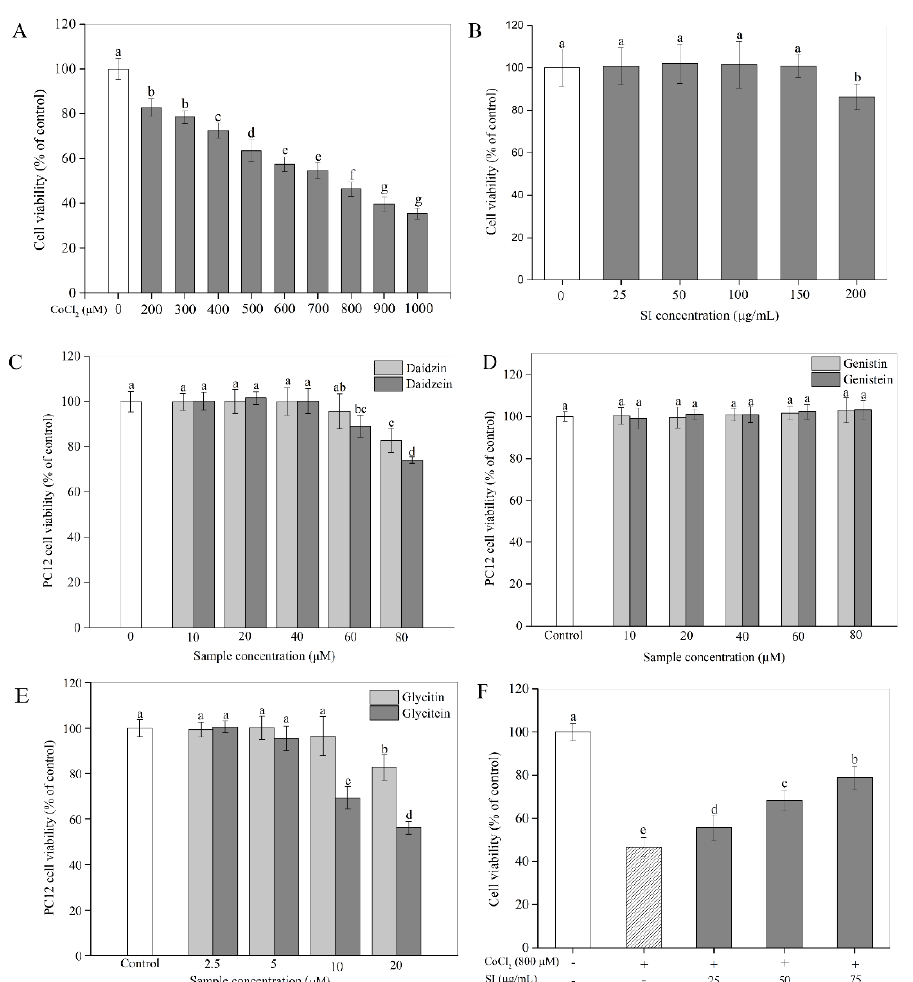
Figure 1. Cytotoxicity and the protective effect of SIs on CoCl 2 − induced cell viability loss. ( A ) Cyto- toxicity of CoCl 2 . ( B ) Cytotoxicity of SIs. ( C ) Cytotoxicity of daidzin and daidzein. ( D ) Cytotoxicity of genistin and genistein. ( E ) Cytotoxicity of glycitin and glycitein. ( F ) The protective effect of SIs on CoCl 2 − induced cell viability loss. Means with different small letters were significantly different ( p < 0.05).